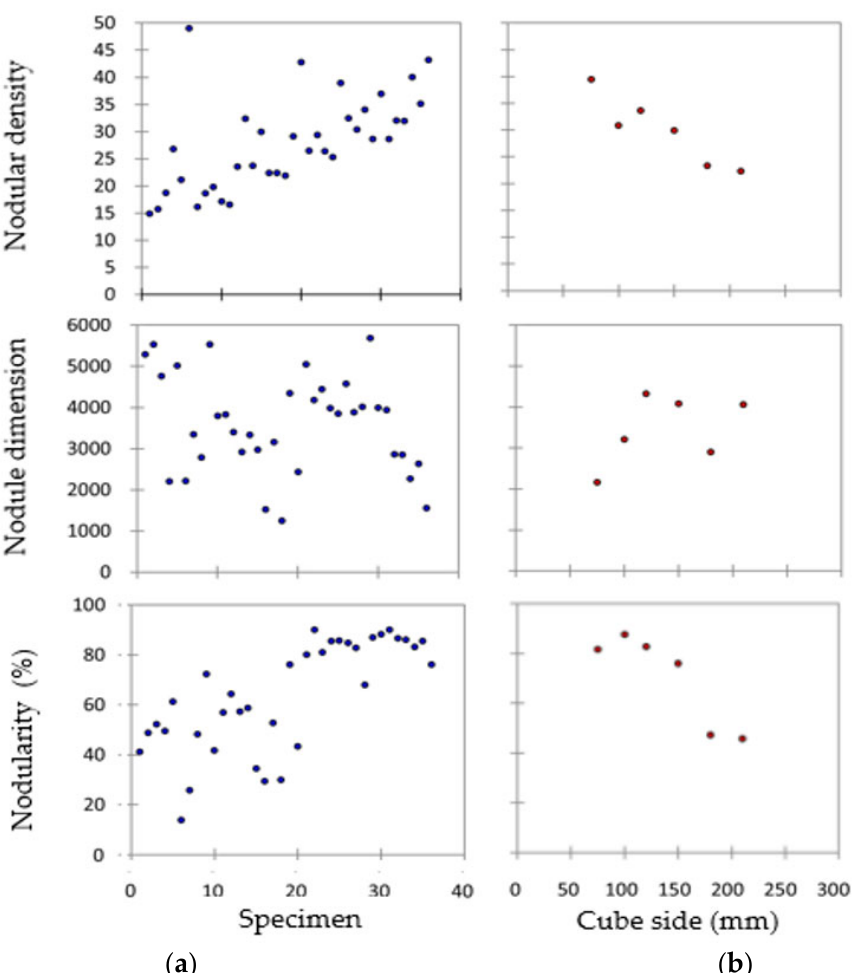
Figure 9. Microstructural information about the graphite nodules (such as the density, dimension and nodularity) in the case of: ( a ) a single specimen, ( b ) average values of specimens from the same cube side.